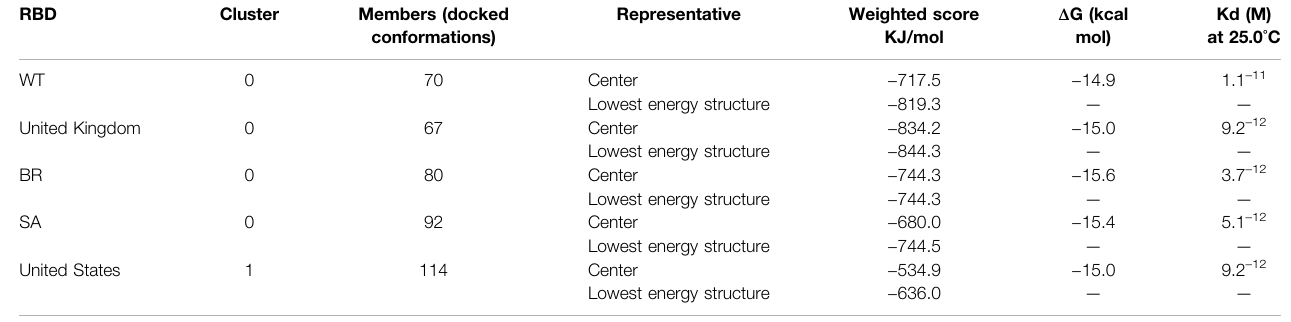
TABLE 1 | Weighted scores, binding af fi nity ( Δ G), and dissociation constant (Kd) of the interaction of each RBD with bromelain. RBD